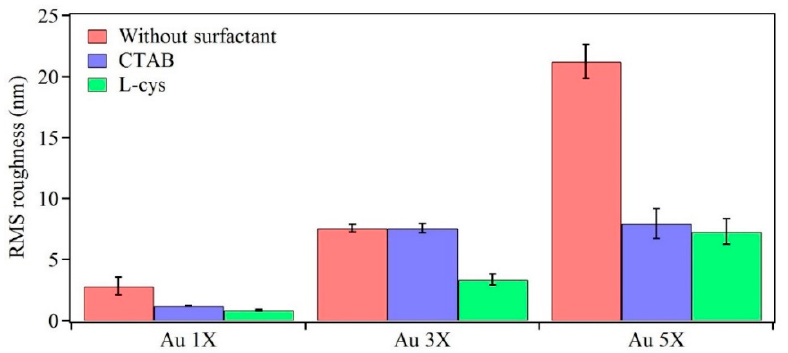
Figure 8. Representative AFM topography maps of the Au samples after one (1X), three (3X), and five